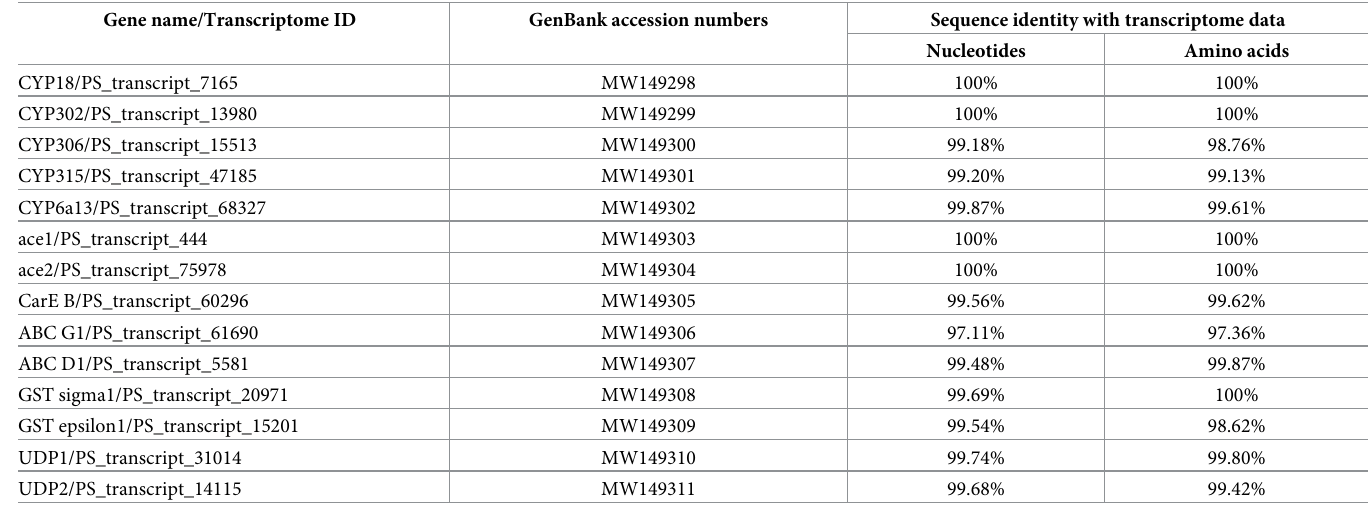
Table 2. Sequence validation by